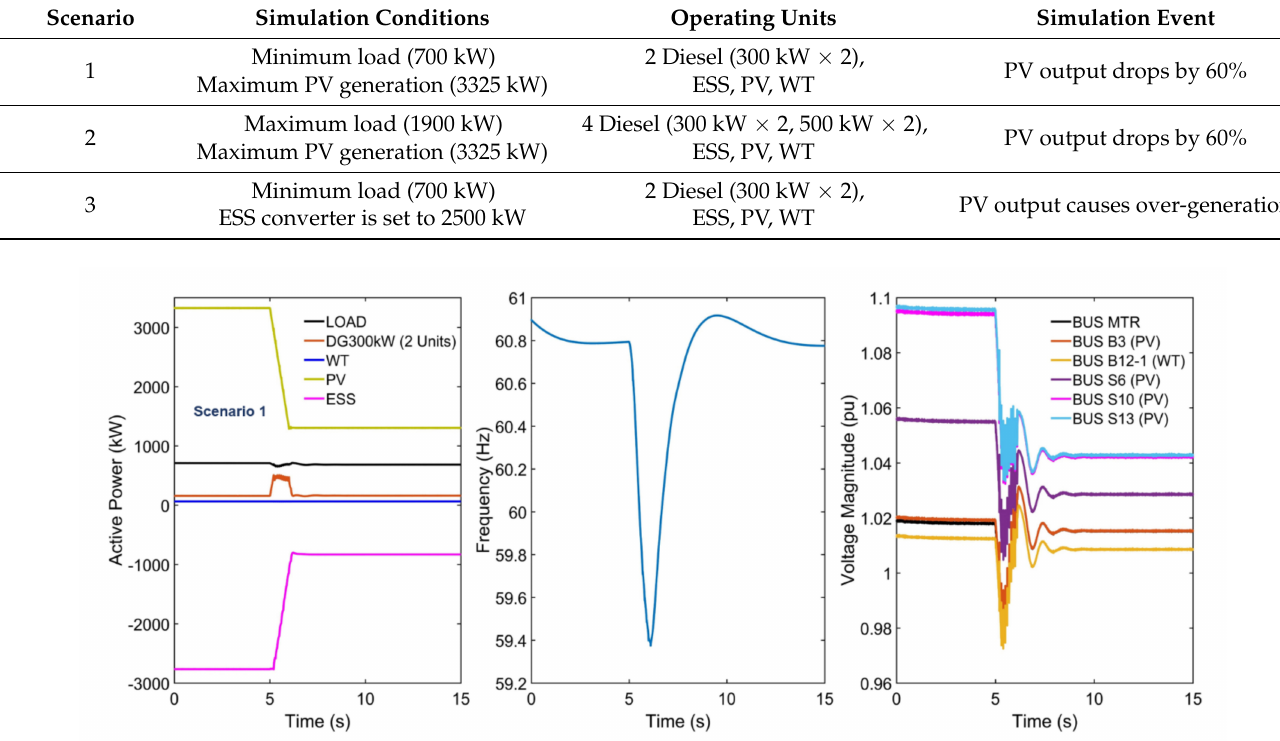
Table 2. Description of dynamic simulation scenarios.